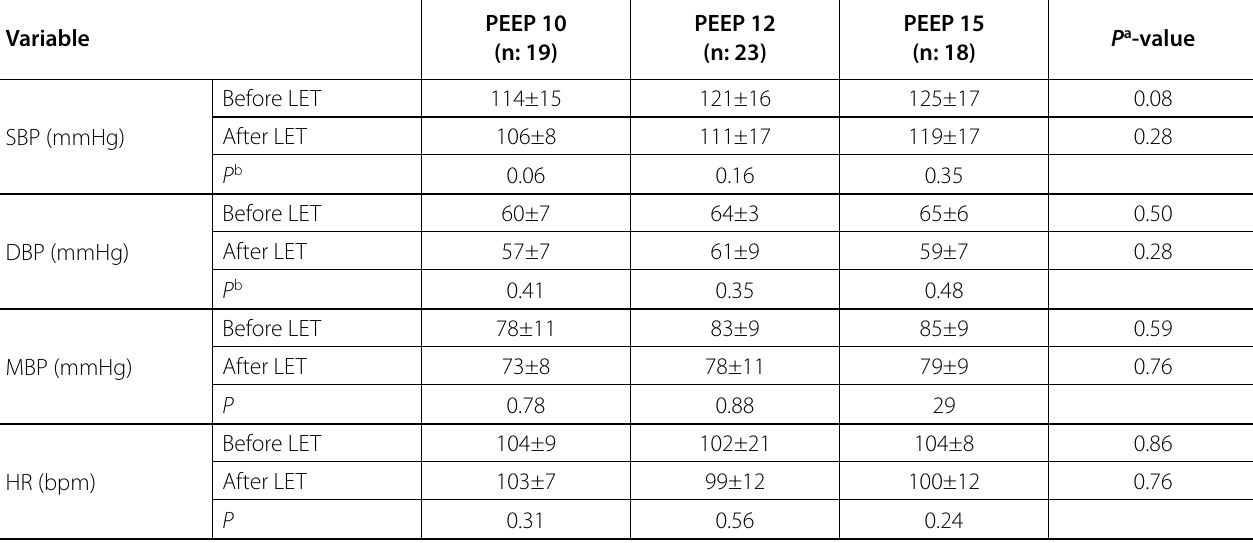
Table 3 . Hemodynamic impact of different levels of PEEP in patients submitted to CABG.